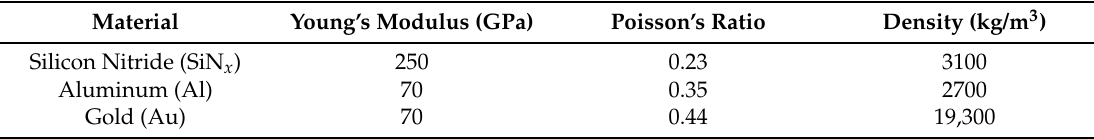
Table 2. Material properties of the three-layer CMUT